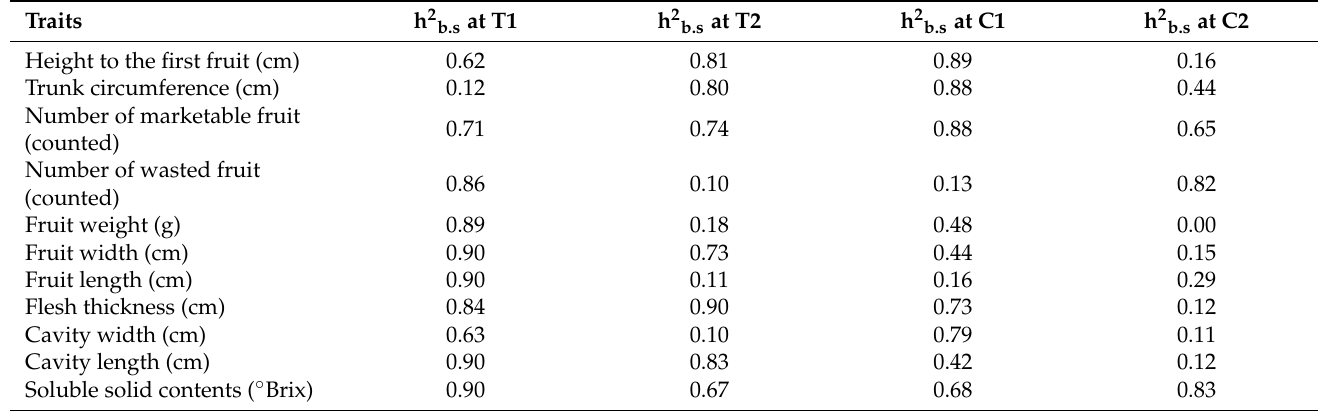
Table 4 . F5 RIL ranked for the breeding value or genetic worth (BLUPs) of each trait in the Table- lands environment (T1 and T2) compared to commercial RB1.